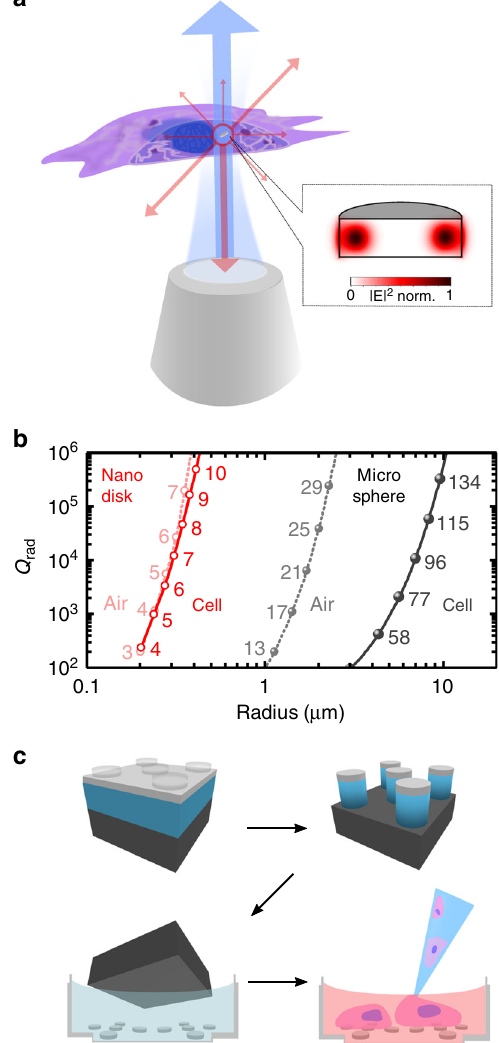
Fig. 1 Concept and modeling of intracellular nanodisk lasers. a Illustration of a semiconductor nanodisk laser internalized into a cell. The disk is optically pumped through a microscope objective (blue) with laser emission (red) collected by the same objective. Insert shows the calculated pro fi le of the lowest radial order transverse electric (TE) mode for a 750 nm diameter disk made of a GaInP/AlGaInP quantum-well structure. b Finite element modeling of the radiative Q -factor of lowest radial order TE modes in whispering gallery mode micro-resonators with different radii. Comparison between GaInP/AlGaInP nanodisks and polystyrene microspheres, both placed either in air or within a cell. Numbers next to each symbol indicate the angular quantum number of the corresponding mode; the vacuum wavelength for all modes was kept fi xed at 680 nm. Lines are guides to the eye. c Schematic illustration of the nanolithography based fabrication of nanodisk lasers, the under-etch process for transfer into cell nutrient medium, and the subsequent culture of cells for disk